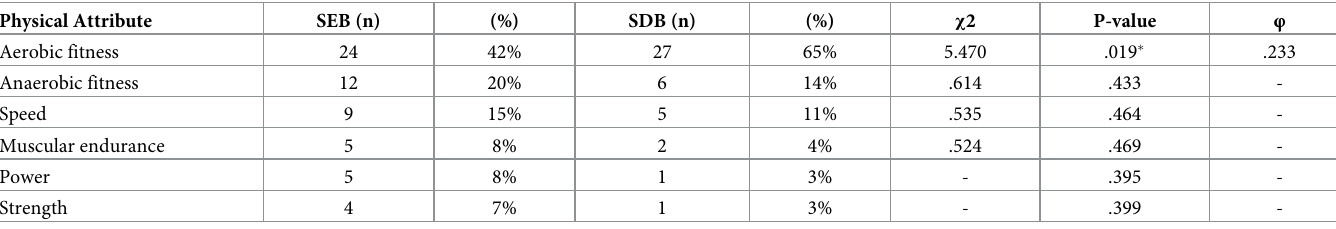
� denotes significant association between competitor level and perceived importance of physical attributes (P �